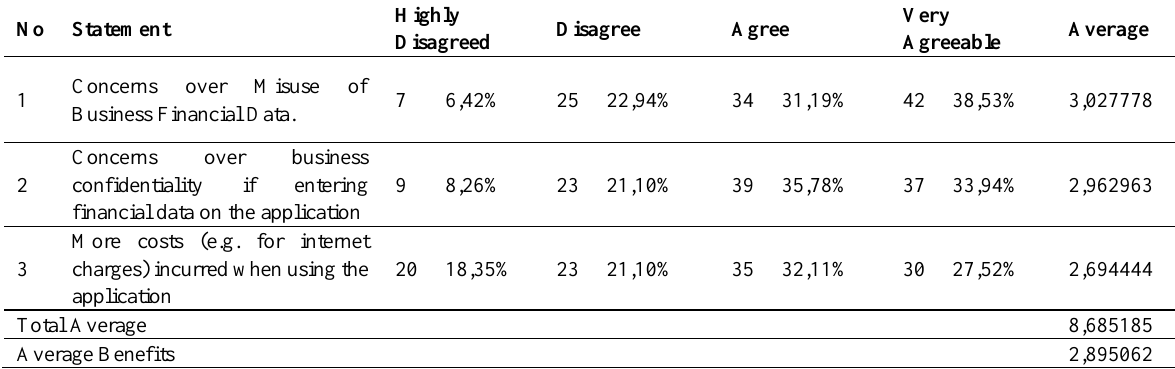
Table 3: Responses and Average